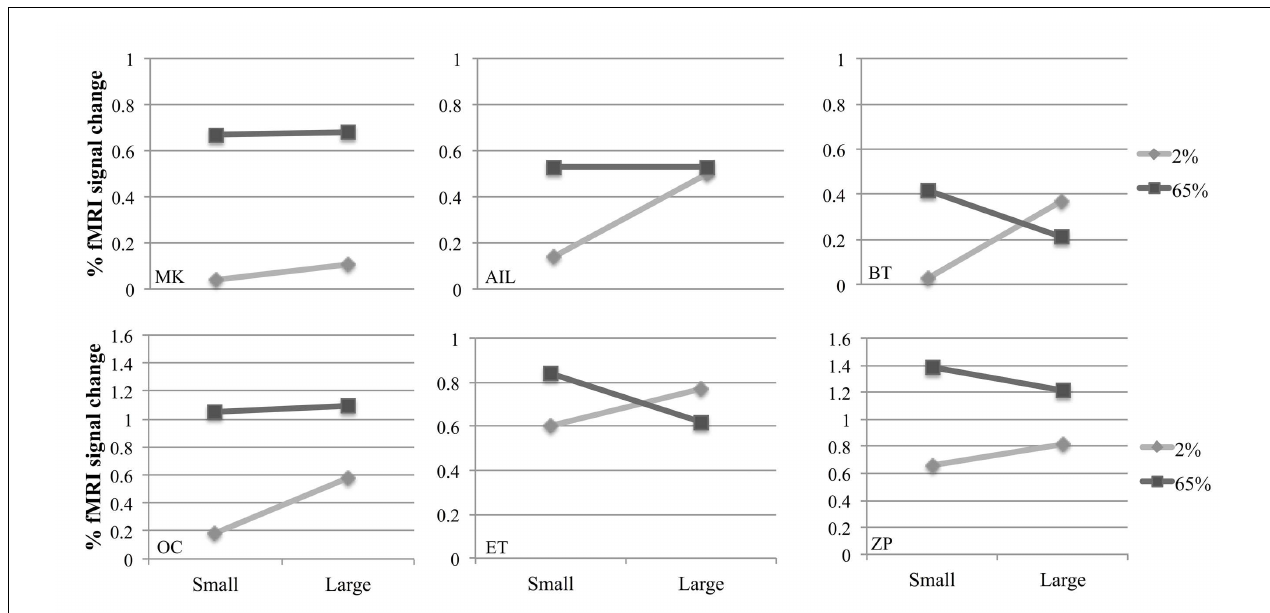
FIGURE 3 | Individual results from six participants in the fMRI experiment. Points represent fMRI response amplitudes in the middle temporal (MT) regions of interest (ROIs) for small and large stimuli.